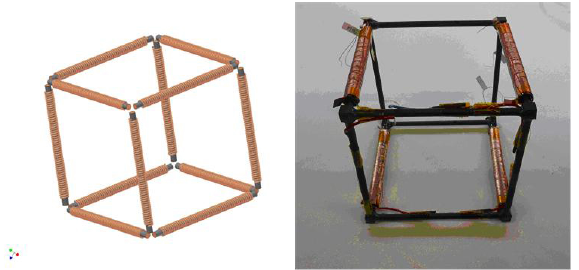
Figure 2. Cubic induction sensor diagram (left picture) and 85cm × 85cm × 85cm prototype (right